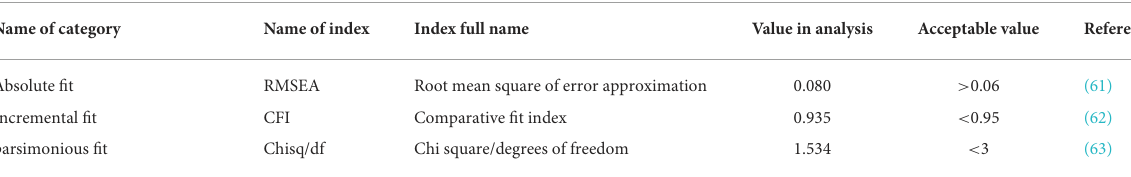
TABLE 5 SEM, model fitness tests. SEM, model fitness tests